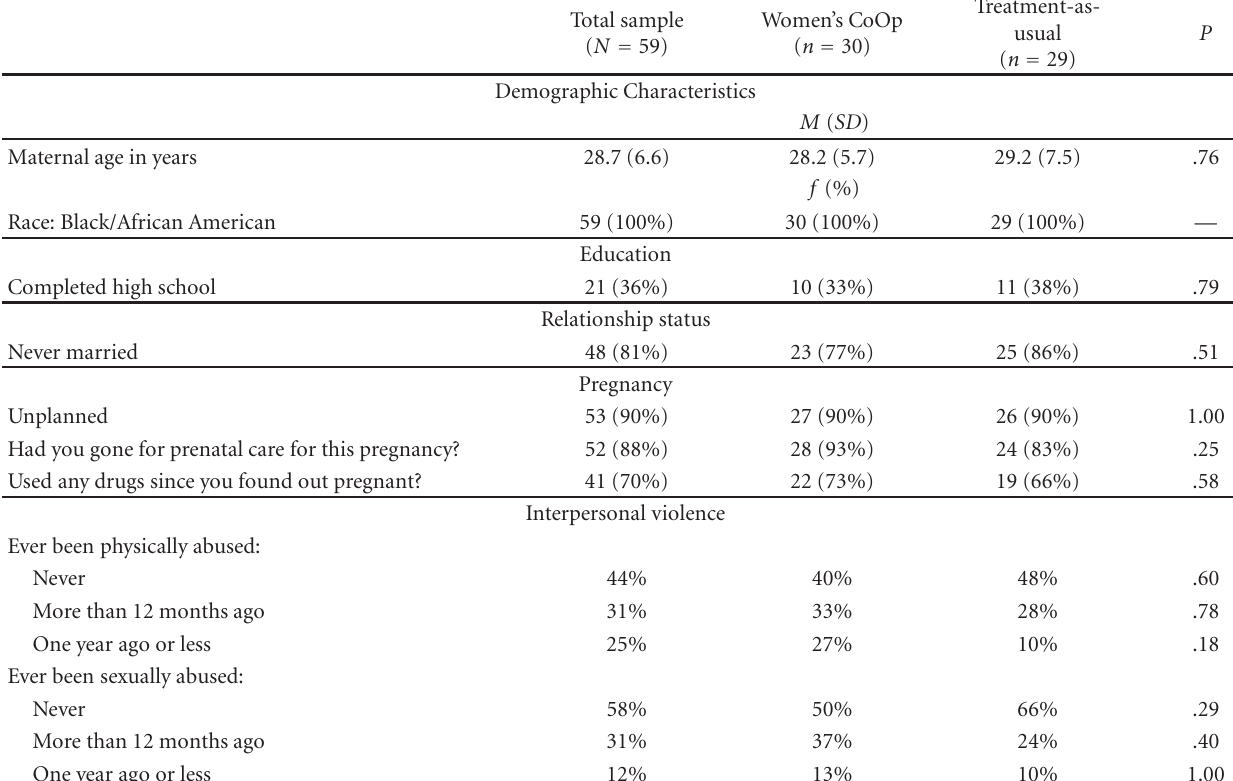
Table 1: Baseline demographic and background characteristics for the total sample and the Women’s CoOp for Pregnant African-American Women and treatment-as-usual